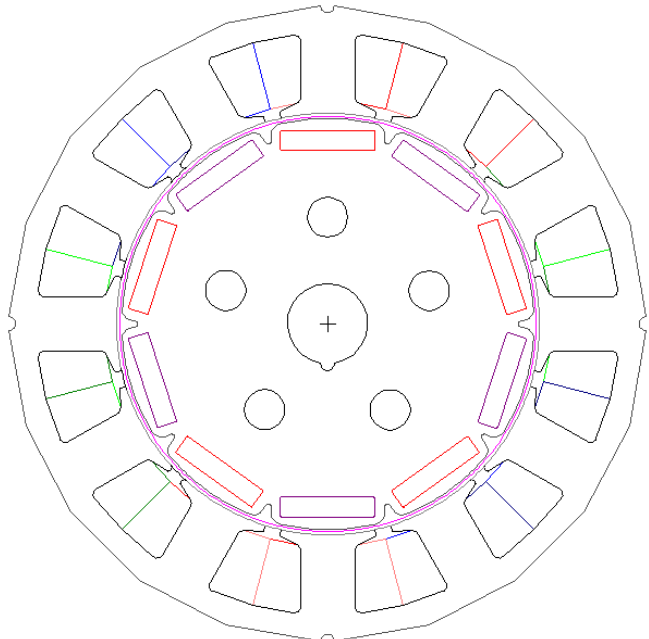
Figure 2. Structure of a 10-pole, 12-slot